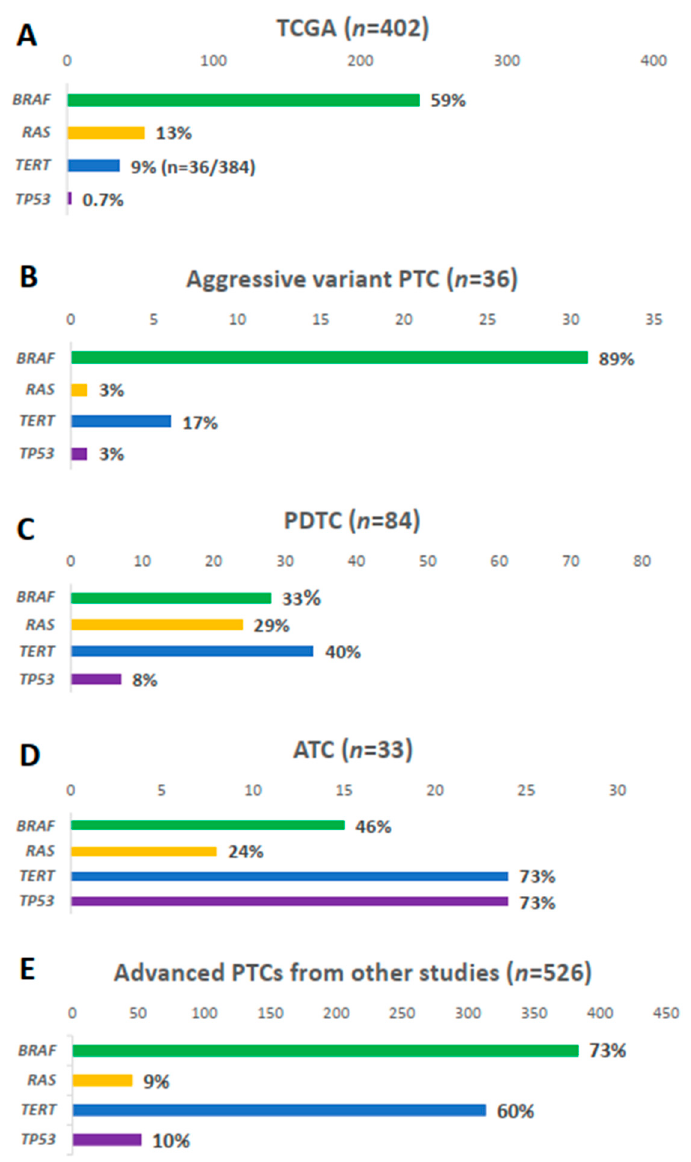
Figure 2. Comparison of BRAF, RAS, TERT promoter, and TP53 mutations: ( A ) papillary thyroid carcinoma (PTC) from The Cancer Genome Atlas (TCGA); ( B ) aggressive variants of PTC in current study; ( C ) poorly differentiated carcinoma (PDTC) and ( D ) anaplastic thyroid carcinoma (ATC) from the Memorial Sloan Kettering Cancer Center (MSKCC) group; ( E ) advanced PTCs from other studies [17,19–21]. Table 2. Comparison of mutational profiles in pathological subtypes of thyroid